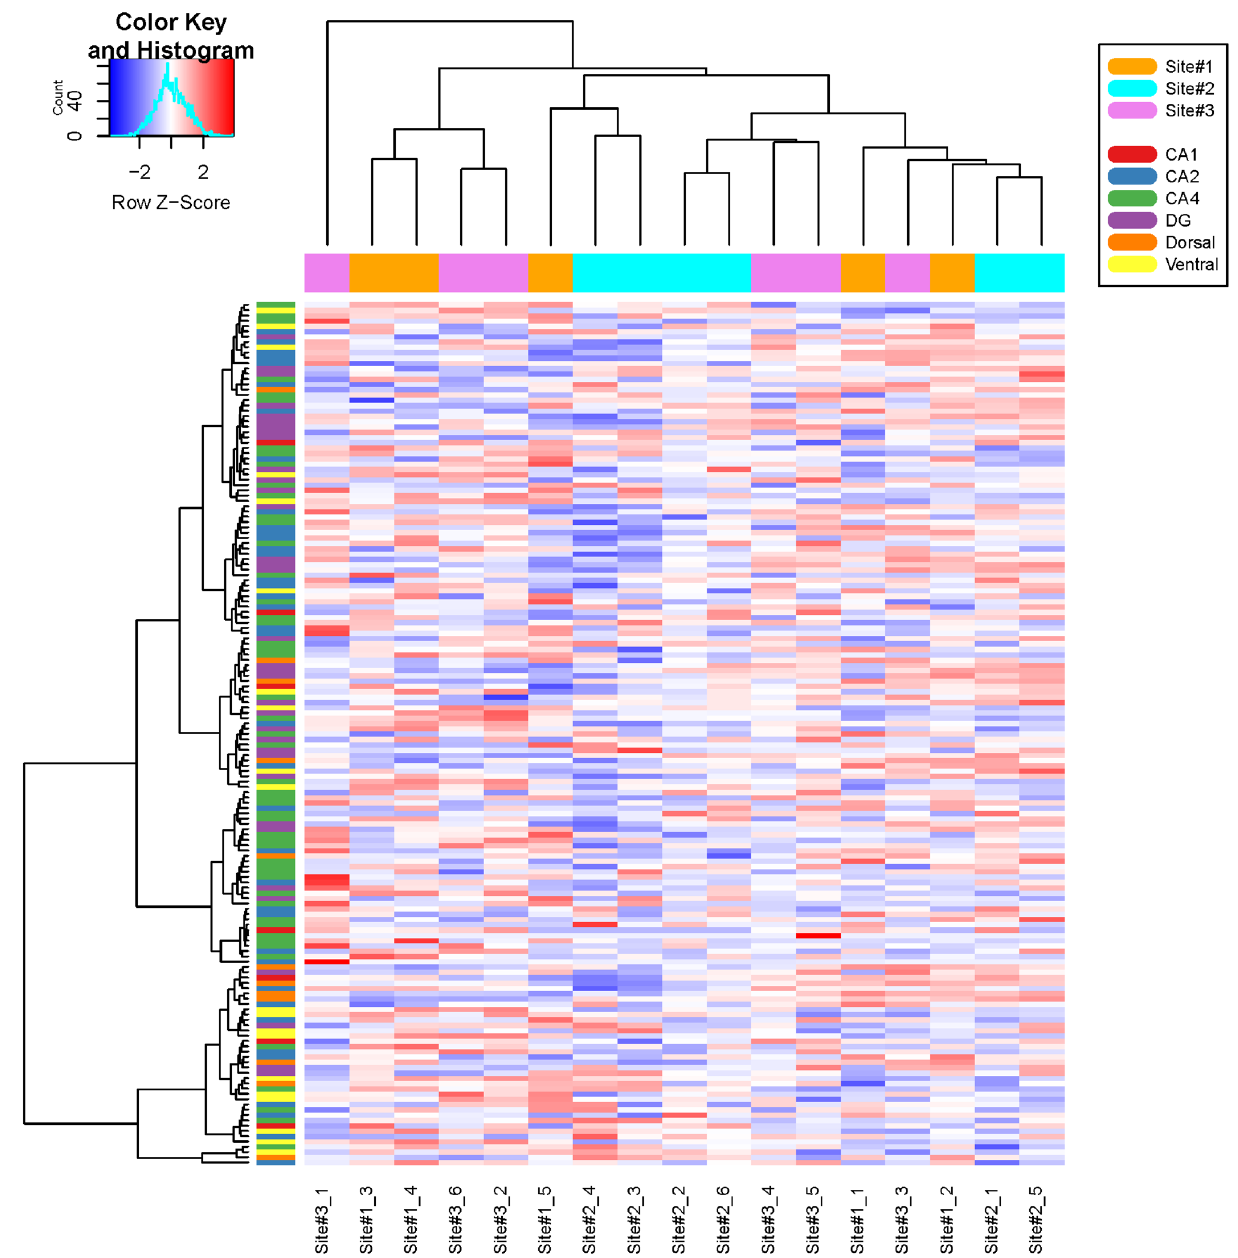
Figure 3. Expression heatmap of region-specific hippocampal markers. A heatmap of row-scaled 164 hippocampal markers was generated using Euclidean distance and complete linkage on the log 2 -transformed Fragments Per Kilobase Million (FPKM) data. Site #1: Legacy Research, Site #2: Trinity College, and Site #3: the University of Alabama at Birmingham. Hippocampal regions: CA1, CA2, CA4, DG (dentate gyrus), dorsal, and ventral regions. The image was created using R 9.1% in exons, and 50.4% in intergenic regions (Supplementary Fig. 2). Each DMC was mapped to a gene with the shortest distance from its transcript starting site and differentially methylated genes (DMG) were identified as having at least one mapped DMC. We also examined the correlation between the methylation levels of DMCs and body weight before animals were killed to assess the effect of different body weight on methylation. While the majority of the Pearson correlations were not significant, a large portion of the DMCs between Site #1 and Site #3 showed a statistically significant correlation with body weight (Supplementary Fig. 3). Differentially expressed genes (DEGs) were identified using DESeq2 and genes with a Benjamini–Hochberg adjusted p value < 0.05. Based on the total number of DMGs and DEGs, the comparison between Site #1 and Site #2 had the smallest numbers of DMGs (n = 1,49) and DEGs (n = 58), suggesting that these two sites had the most similar DNA methylation and gene expression profiles among the three sites, which is also supported by the hierarchical clustering of samples (Supplementary Fig. 4). The comparison between Site #2 and Site #3 was the